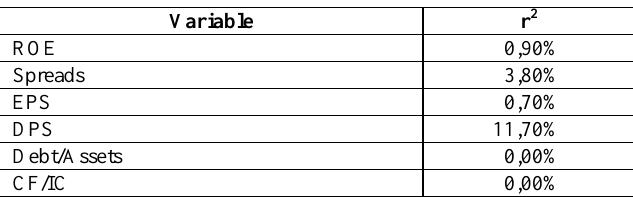
Table 3: Simple linear regression of shareholders’ returns with each independent variable using